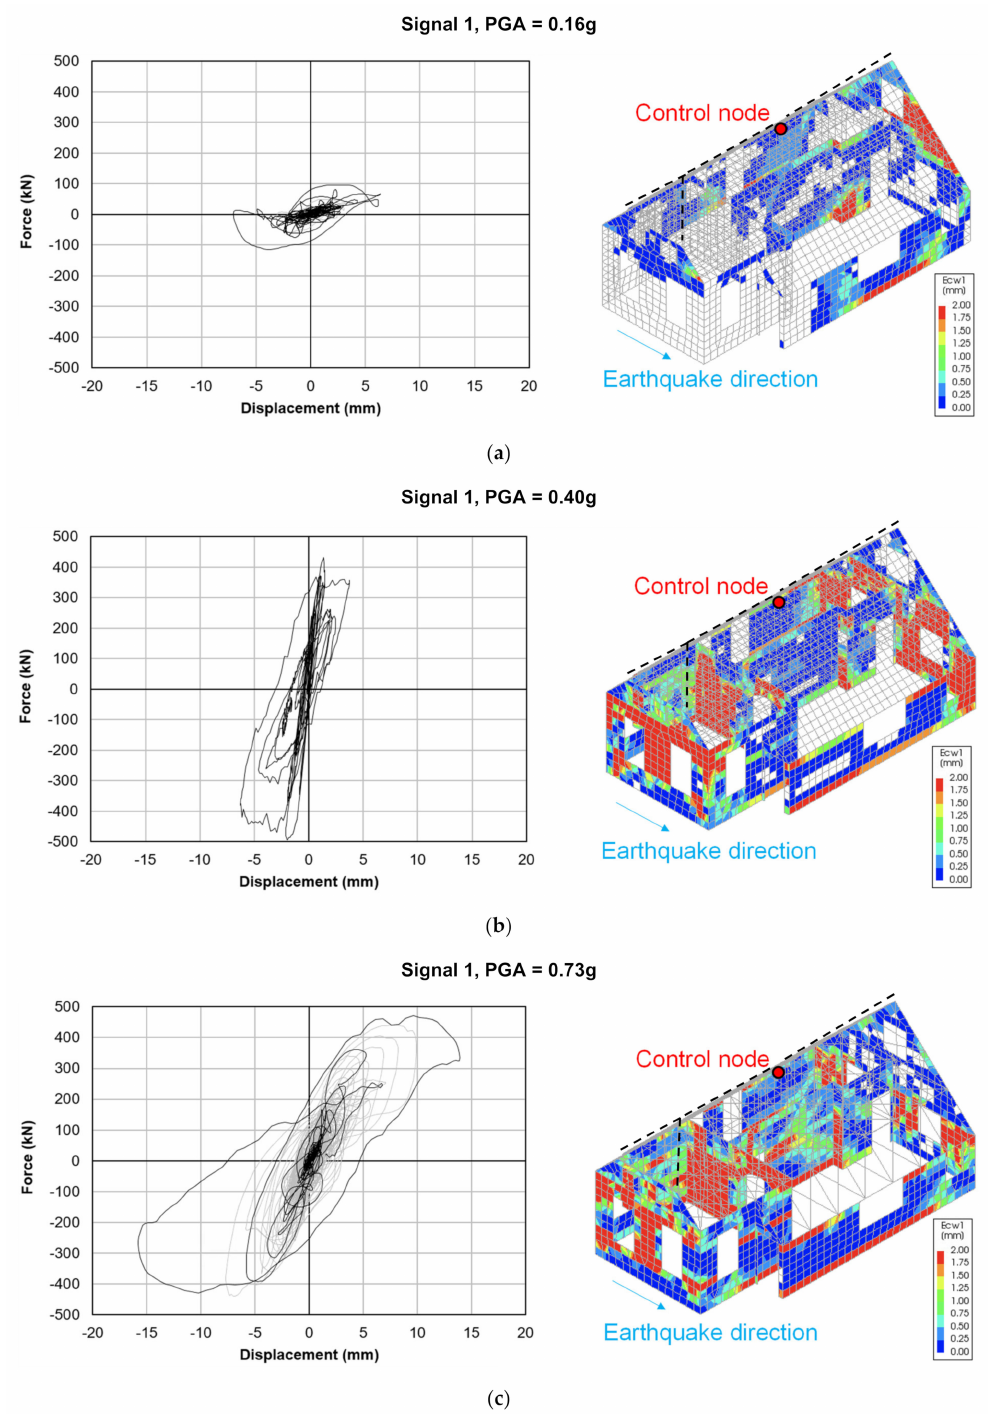
Figure 12. Base shear vs. top roof displacement response and damage level in terms of the principal crack opening (Ecw1) for the three configurations: B1-AB ( a ), B1-RC ( b ), and B1-PP ( c ) at a near-collapse